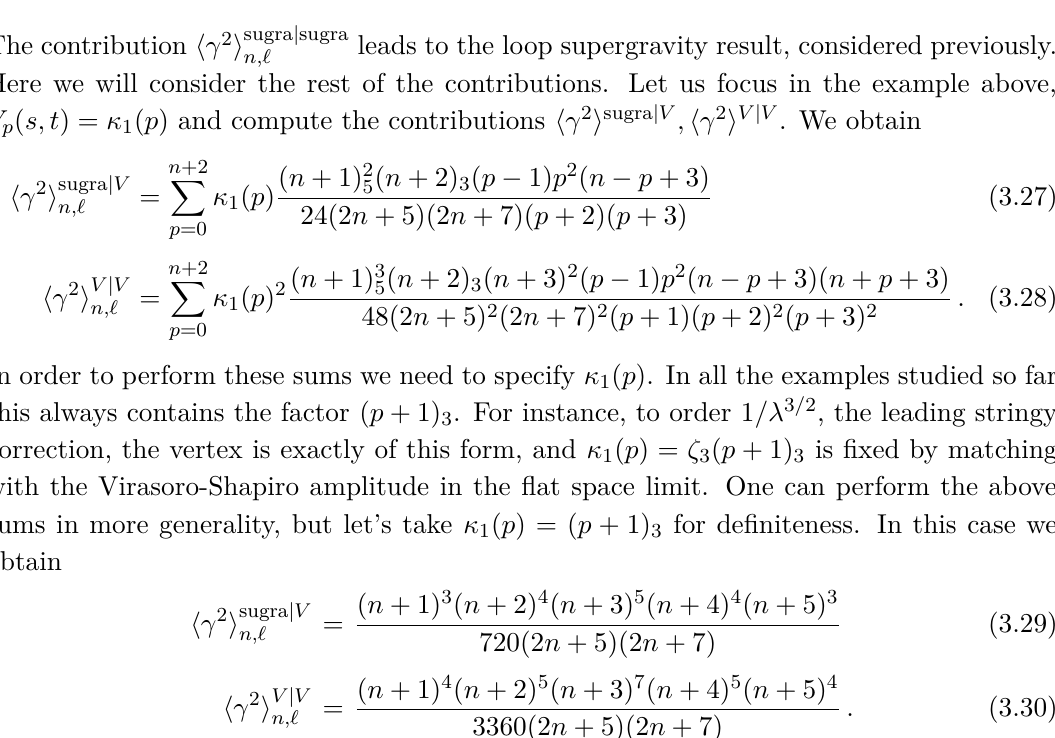
Figure 2 . The fish diagram arises as the “square” of two contact